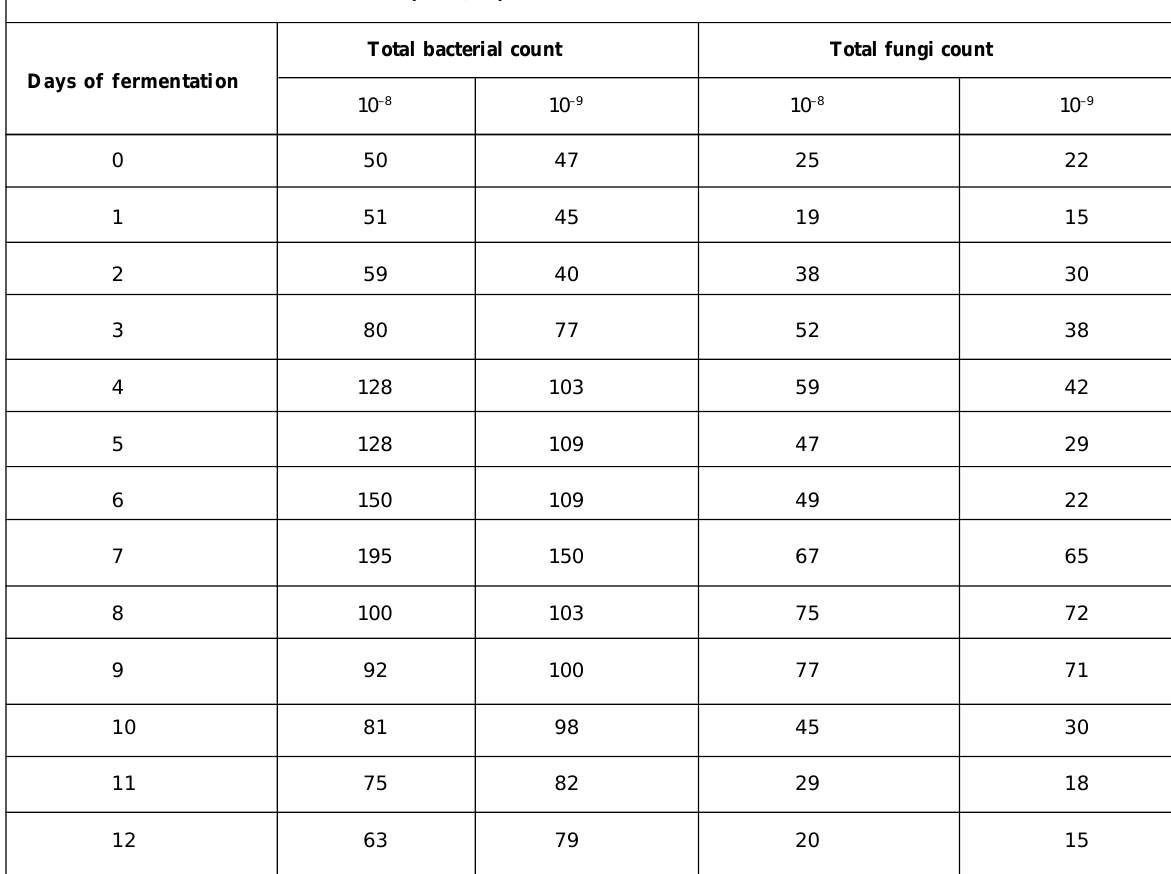
Table 2: Anaerobic microbial counts (CFU/ml) of rumen substrate Total bacterial count Days of fermentation